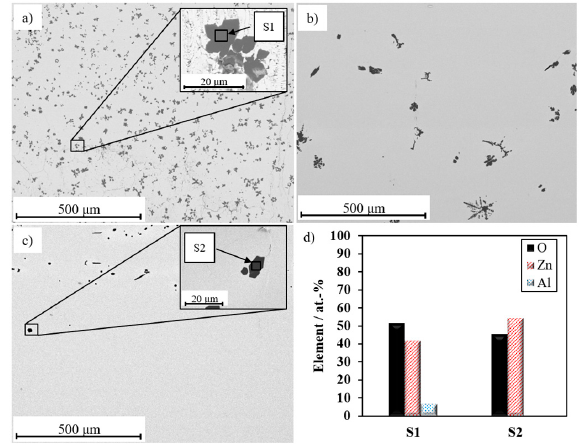
Figure 3. SEM micrographs (back scattered electrons) of cross sections of solidified Bi 2 O 3 -Li 2 O-ZnO glass melted in ( a ) an Al 2 O 3 crucible at 1050 °C, ( b ) in a Pt crucible at 1050 °C, and ( c ) in a Pt crucible at 1200 °C. ( d ) EDX analyses (10 keV).